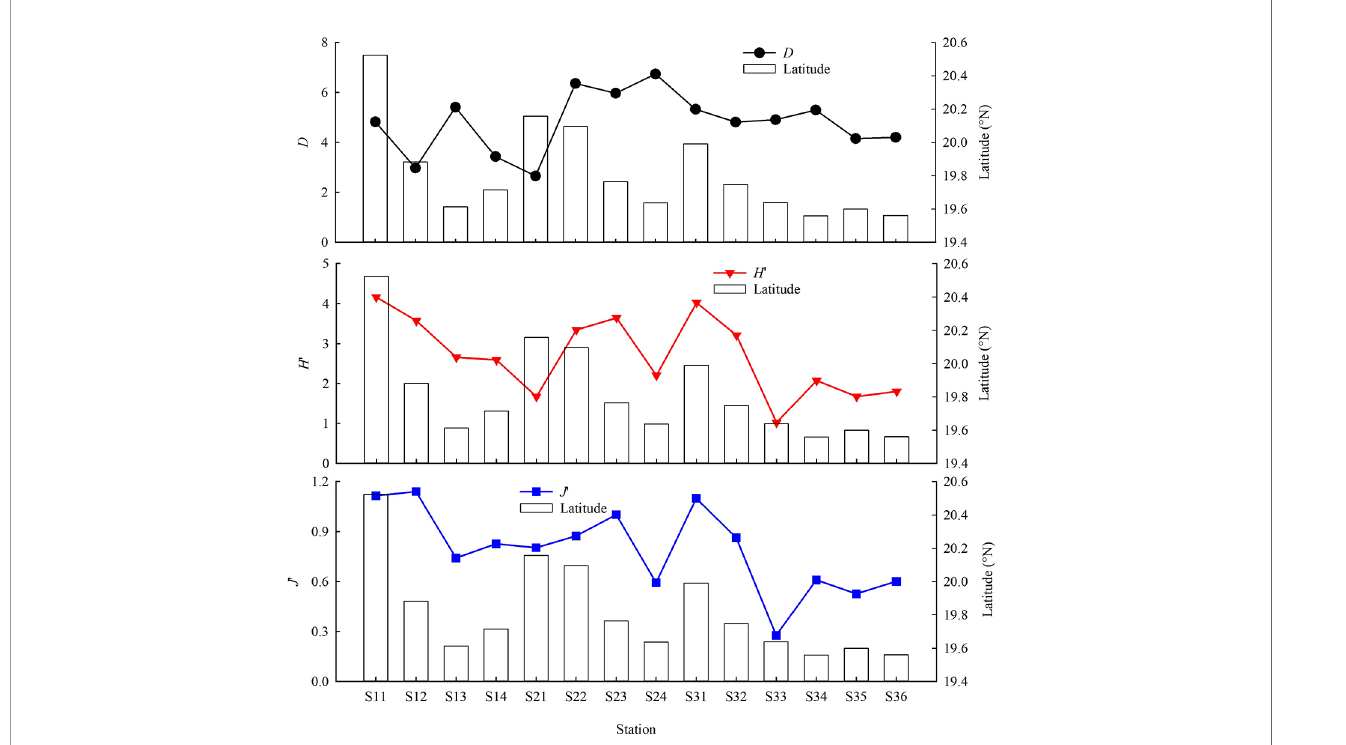
FIGURE 5 | Variation of demersal fi sh diversity index with latitude over the